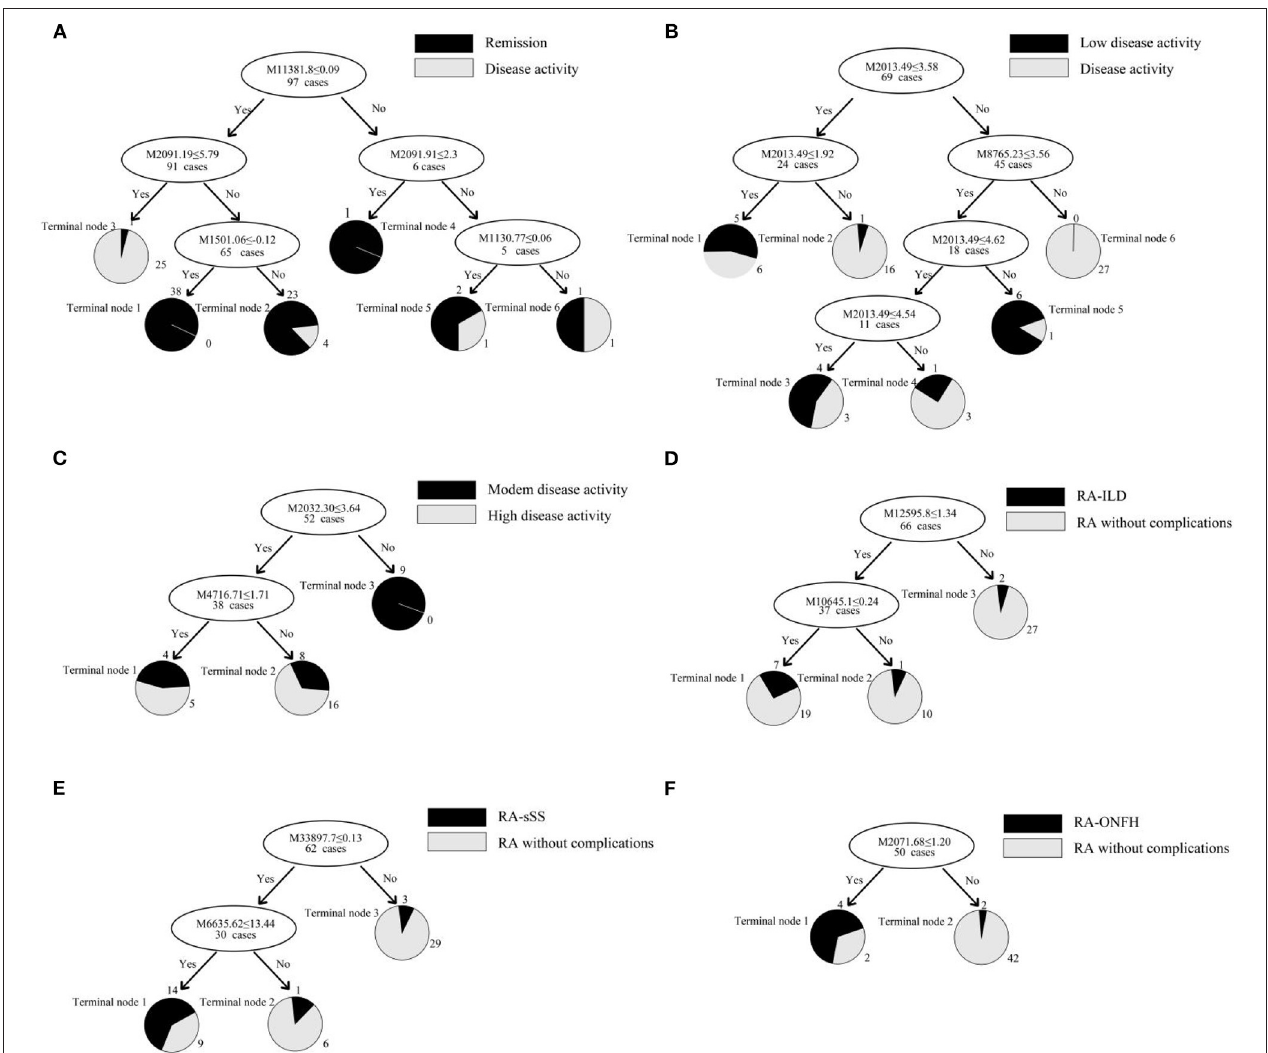
FIGURE 3 | (A–F) Classification tree model for assessing disease activity in RA patients and distinguishing RA patients with complications. The mass-to-charge value in the nodes was followed by lower or equal to intensity value. If the answer to the question in a node of the tree was yes, it proceeded down to the left node, otherwise it proceeded down to the right node. When proceeding to the terminal nodes, the decision tree assigned to samples to different groups. (A) : patients with remission (terminal node 2, 4, and 5) and disease activity (terminal node 1, 3, and 6); (B) : RA patients with low disease activity (terminal node 1, 3, and 5) and other disease activity (terminal node 2, 4, and 6); (C) : RA patients with moderate disease activity (terminal node 2) and high disease activity (terminal node 1 and 3); (D) : RA-ILD (terminal node 1); (E) : RA-sSS (terminal node 1); (F) : RA-ONFH (terminal node 1).